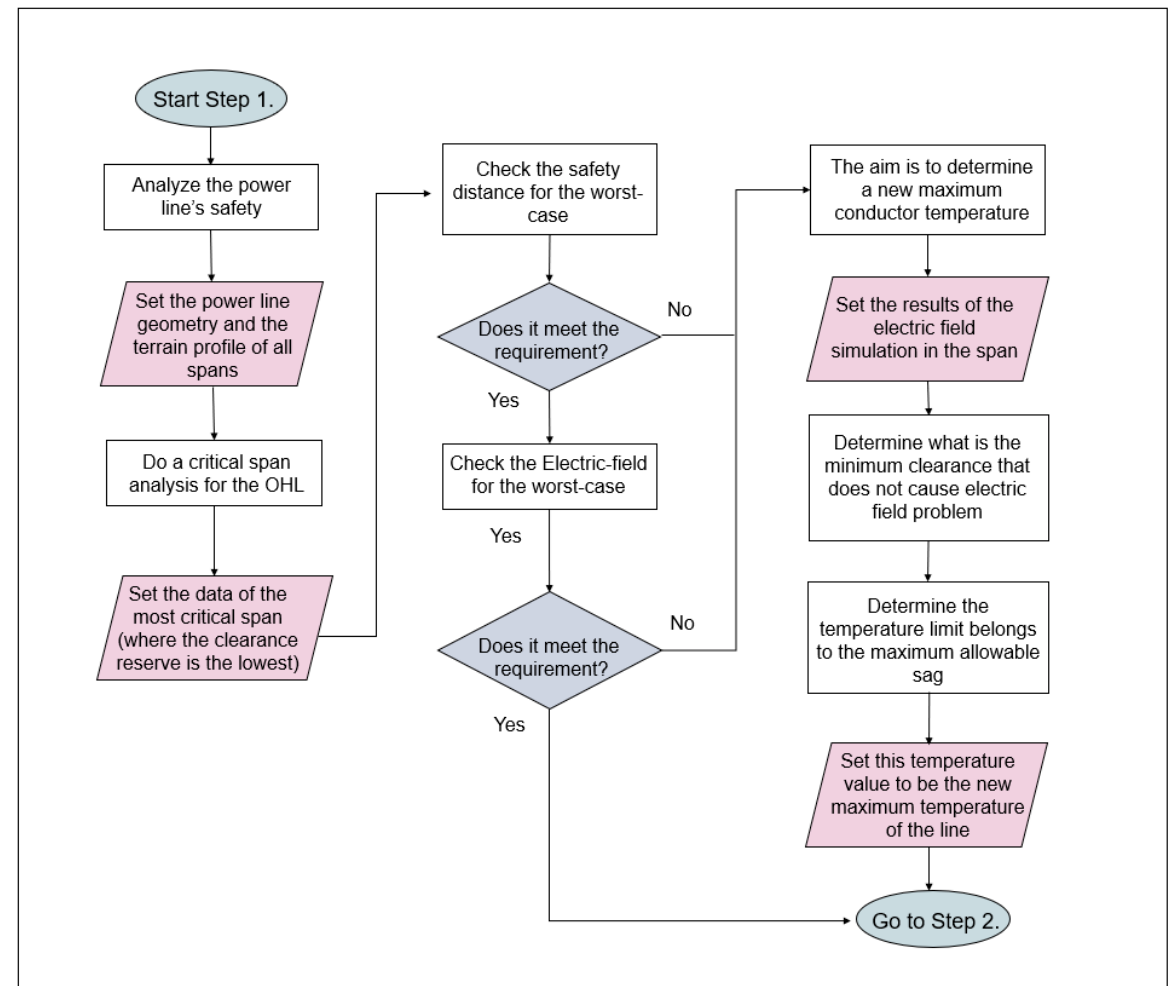
Figure 5. Process drawing of the first step of the new dynamic line rating (DLR)-based expert system.